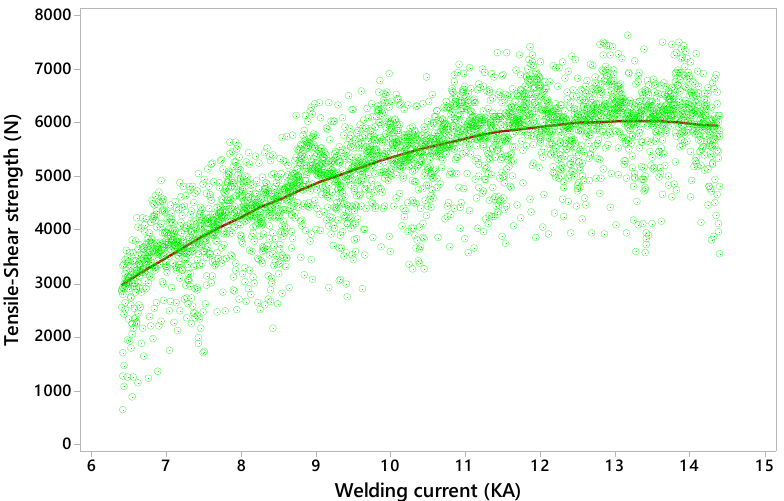
Figure 12. Effect of welding current on TSS of spot welds.